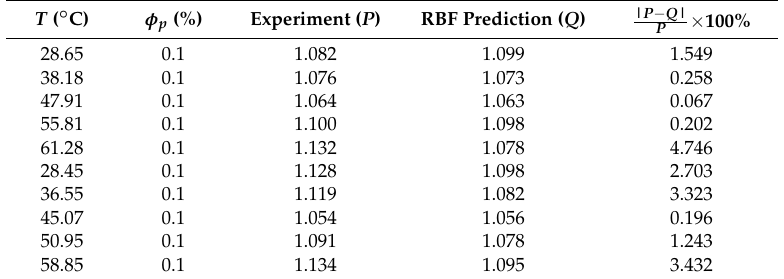
Table 6. Comparisons of the RBF predicted viscosity ratio of SiO 2 -ethylene glycol/water (50:50 by volume ratio) nanofluids with the experimental data of Jamshidi et al. [13].